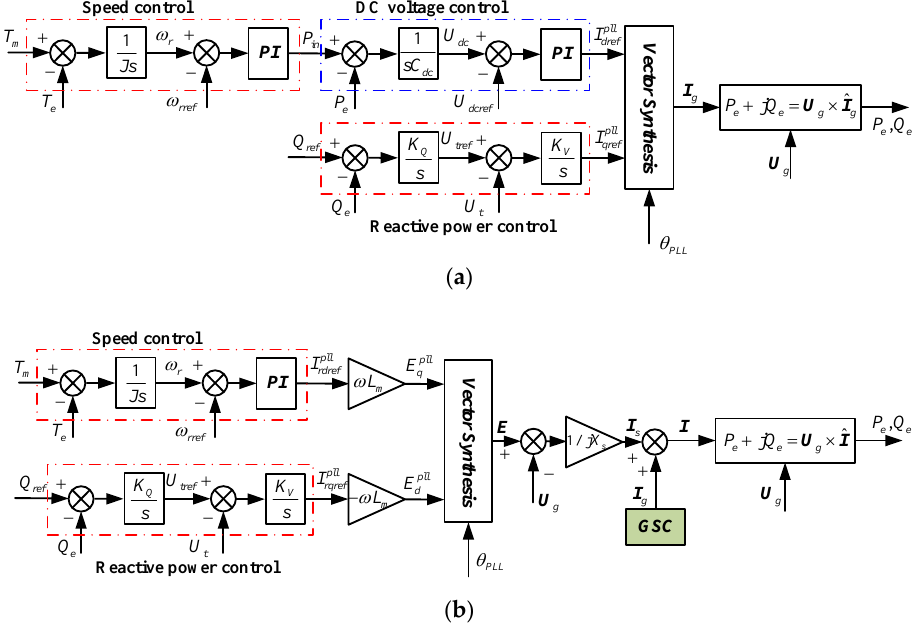
Figure 3. Simplified control block diagram of WTs. ( a ) Type-4 WTs; ( b ) Type-3 WTs ( X s is equivalent impedance between inner potential and grid voltage).